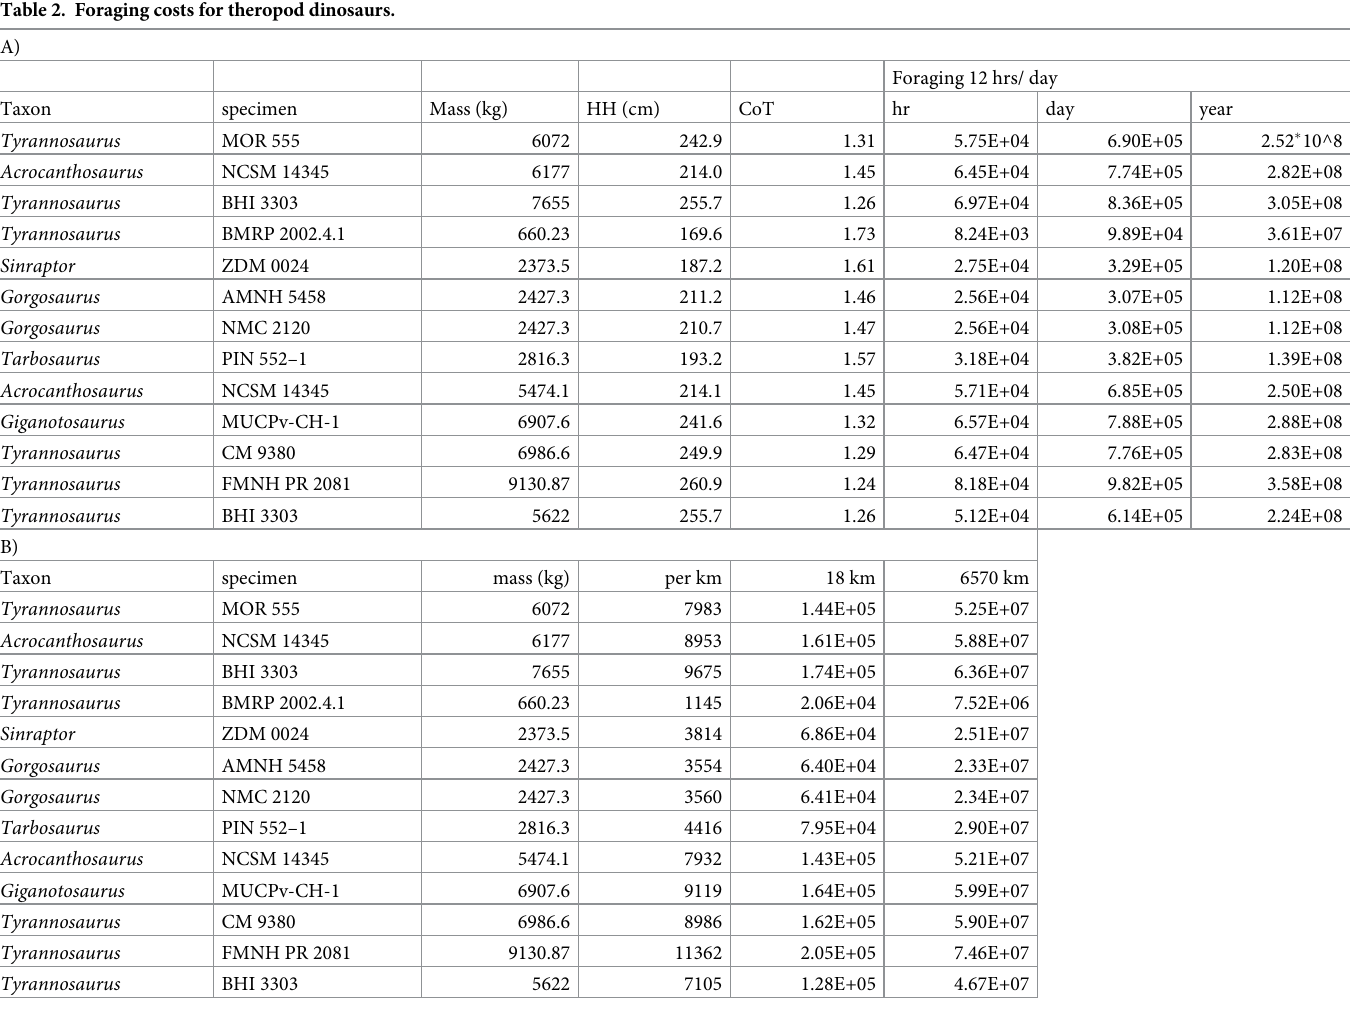
Table 2. Foraging costs for theropod